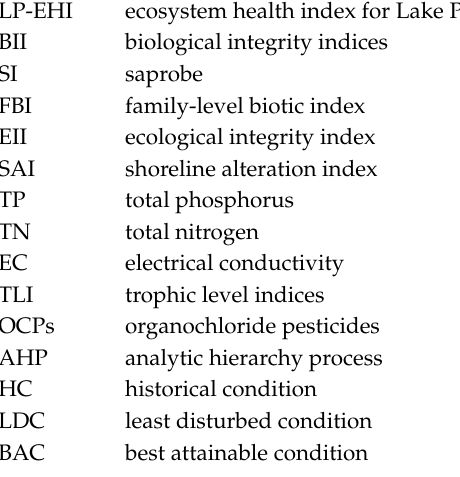
Table S1: Equations for calculating the fifteen level individual